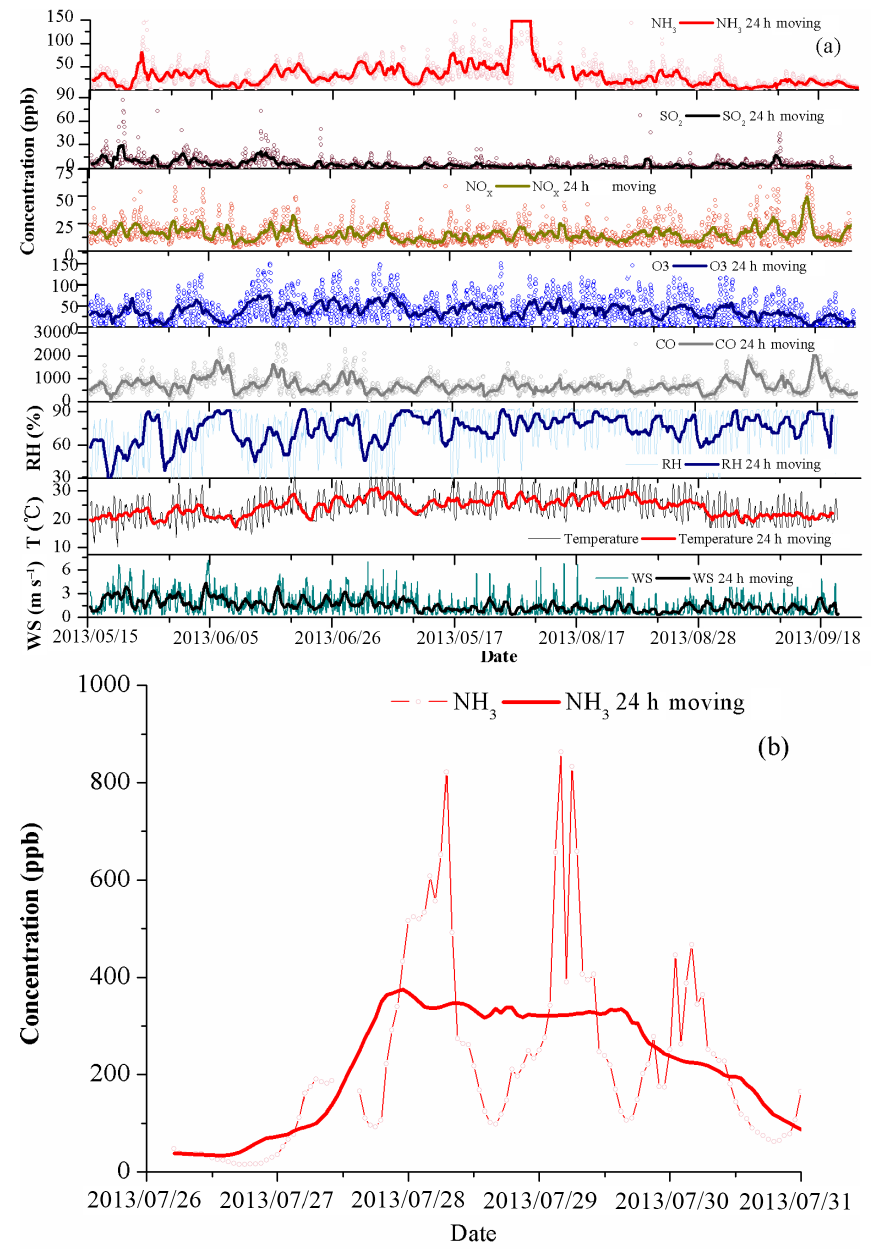
Figure 2. Time series of hourly data of NH 3 , other trace gases, and meteorological parameters measured during the sampling period (a) and a close-up of the period with extremely high NH 3 values during 27–31 July 2013 (b)